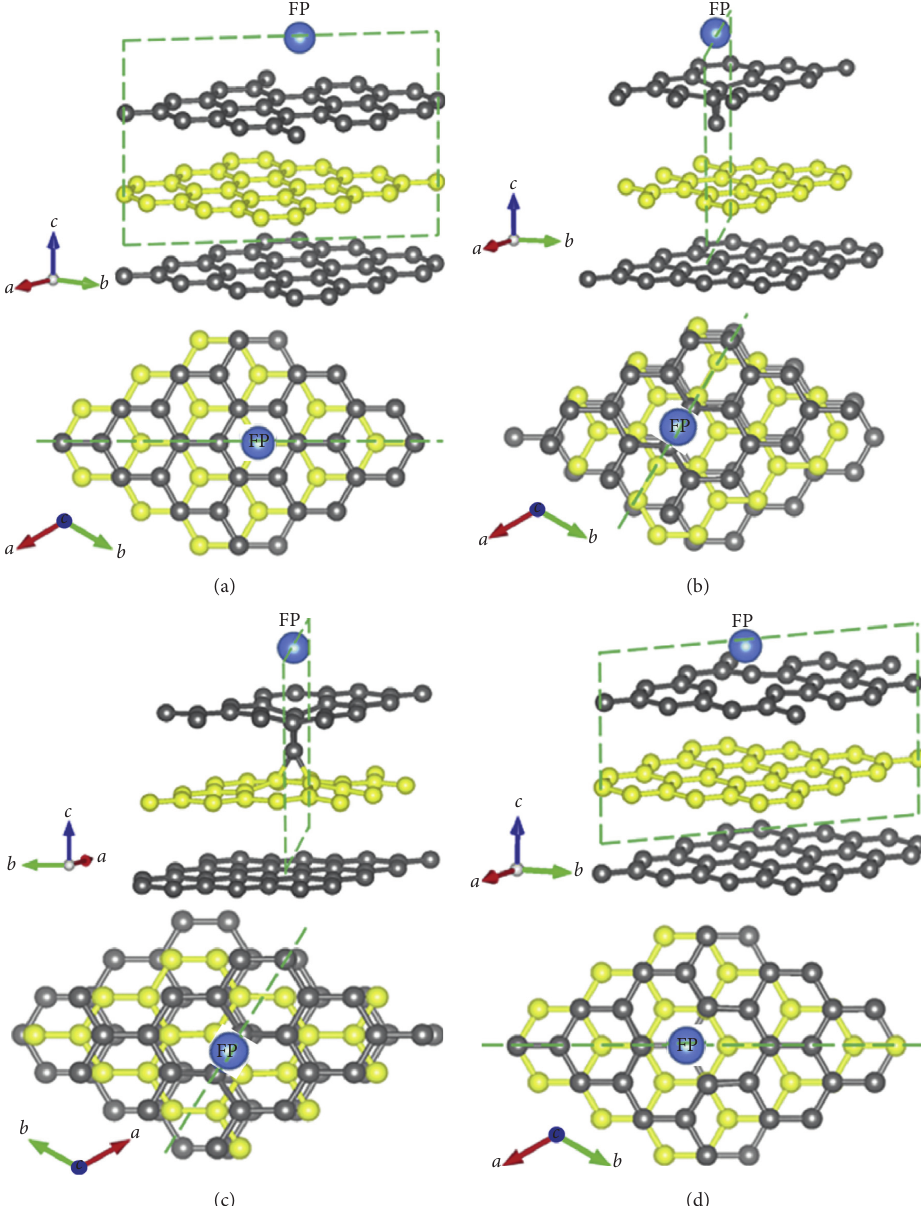
Figure 4: Geometry structures of metal fission product adsorbed on matrix graphite surface: (a) perfect matrix graphite surface; (b) “bridge” and (c) “spiro” interstitial defects; and (d) single vacancy defect. Yellow balls represent the second layer of carbon atoms. Blue balls represent the metal fission products. The dash green lines represent the cross-sectional lines of charge density